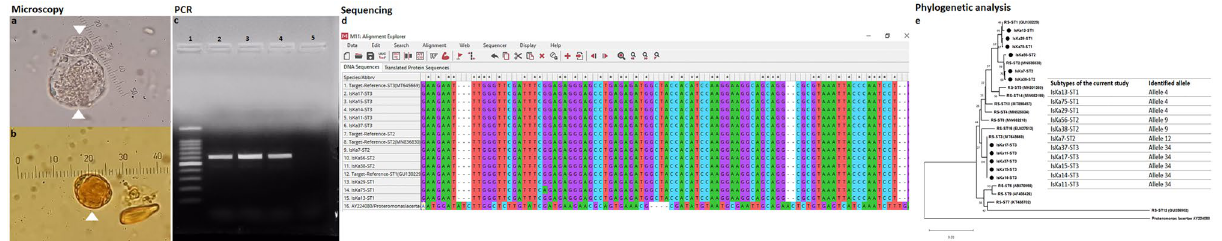
Figure 1. Fecal sample processing steps. ( a ) Blastocystis sp. vacuolar form and intermediate phase form using wet-mount examination. ( b ) Blastocystis sp. vacuolar form using iodine wet-mount examination. ( c )